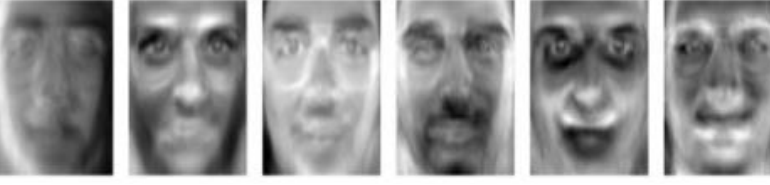
Figure 10. The first five Eigenfaces built from the ORL database [63].